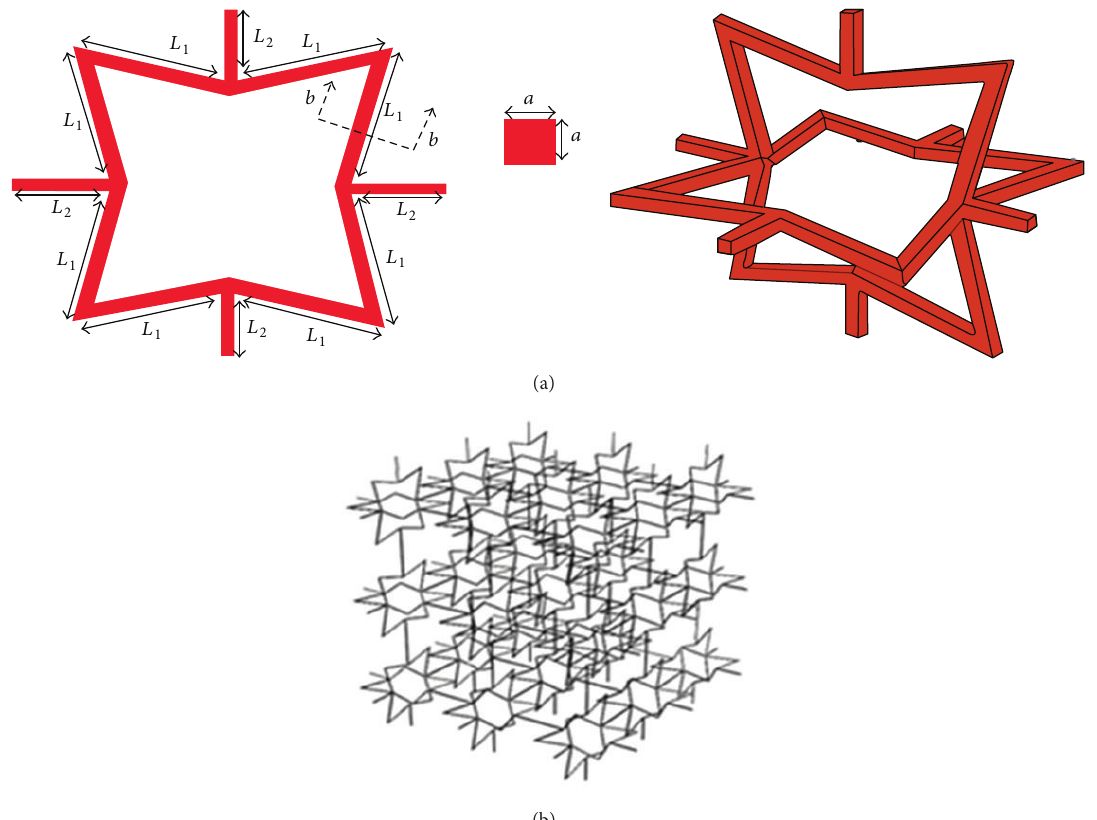
Figure 1: (a) Star honeycomb structure in 2D and 3D. (b) An element of auxetic material made of 3D star honeycomb structures.